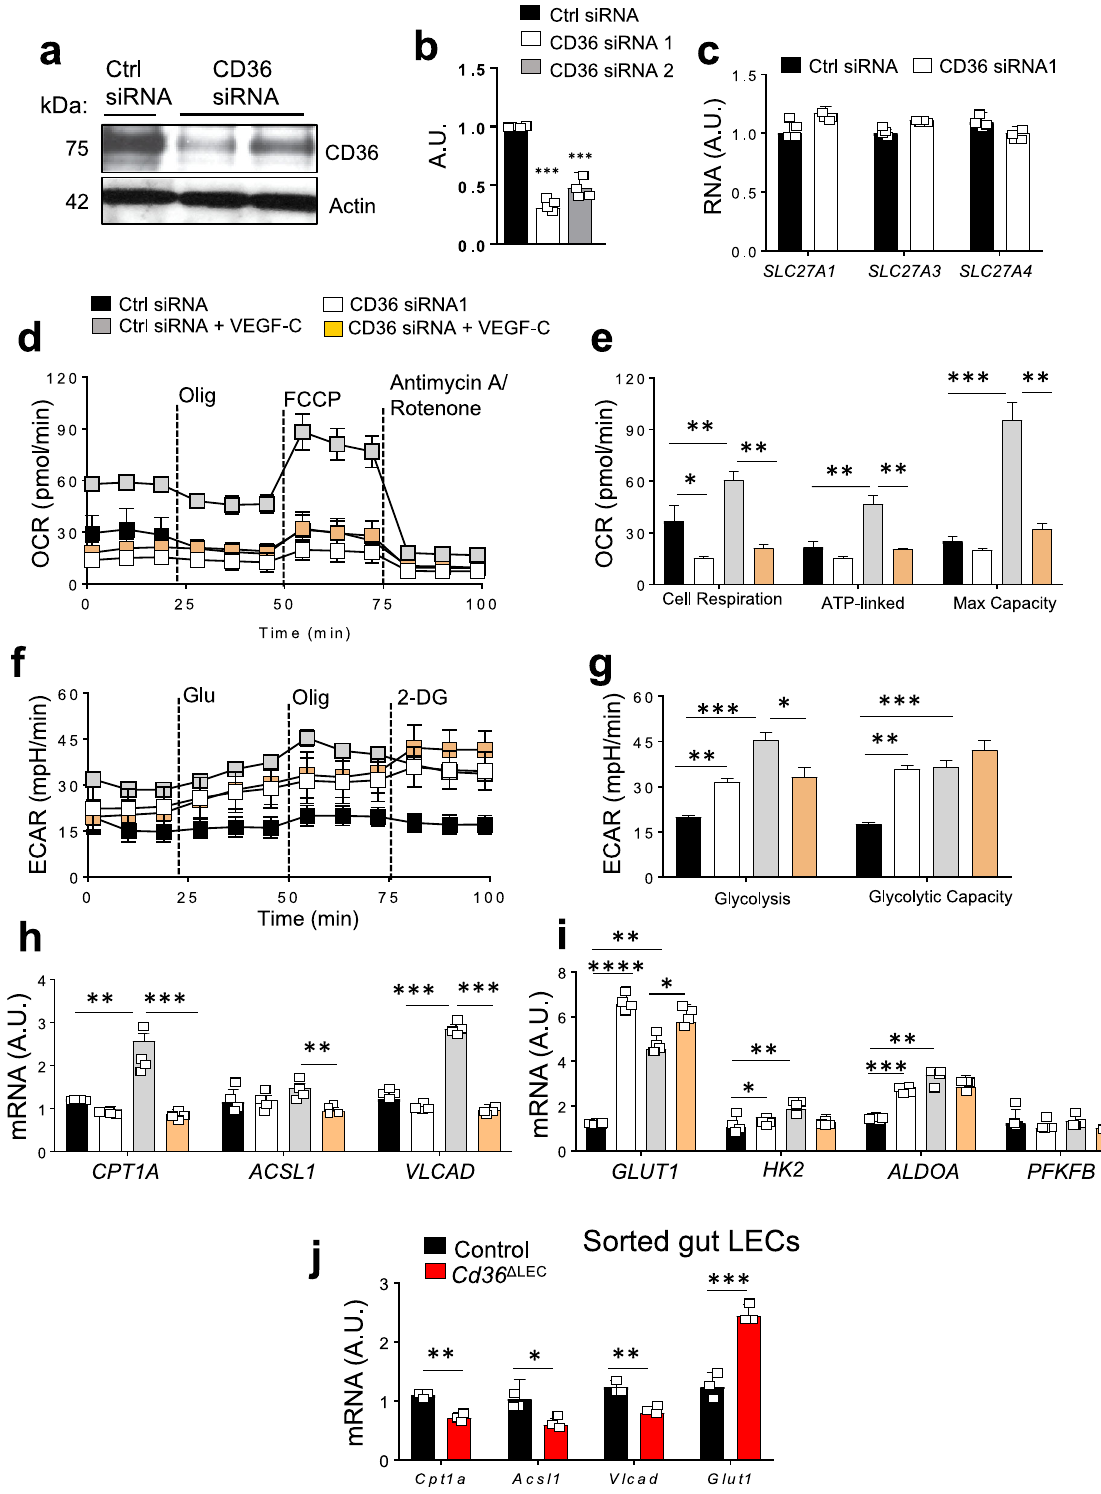
during lymphangiogenesis 29,52 . CD36 silencing reduced VEGF-C action to upregulate gene expression of GLUT1 , HEK2 , and CPT1A and its ability to stimulate cell respiration, glycolysis, cell migration, and tube formation. The defects in tube formation and migration appear mediated by VEGF-C signaling through VEGFR2 and AKT; VEGF-C activation of VEGFR2 Y1175 and AKT S473 was inhibited by CD36 silencing. The VEGFR2 pathway